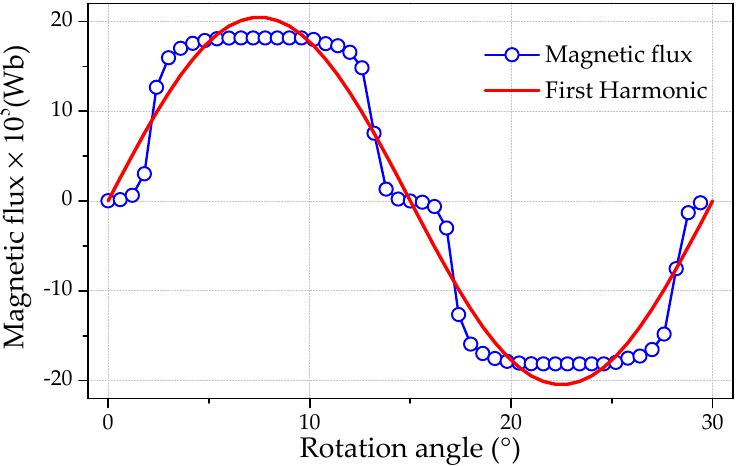
Figure 8. Magnetic flux penetrating a single coil of stator windings as a function of the rotation angle. The solid line represents the first harmonic of magnetic flux.